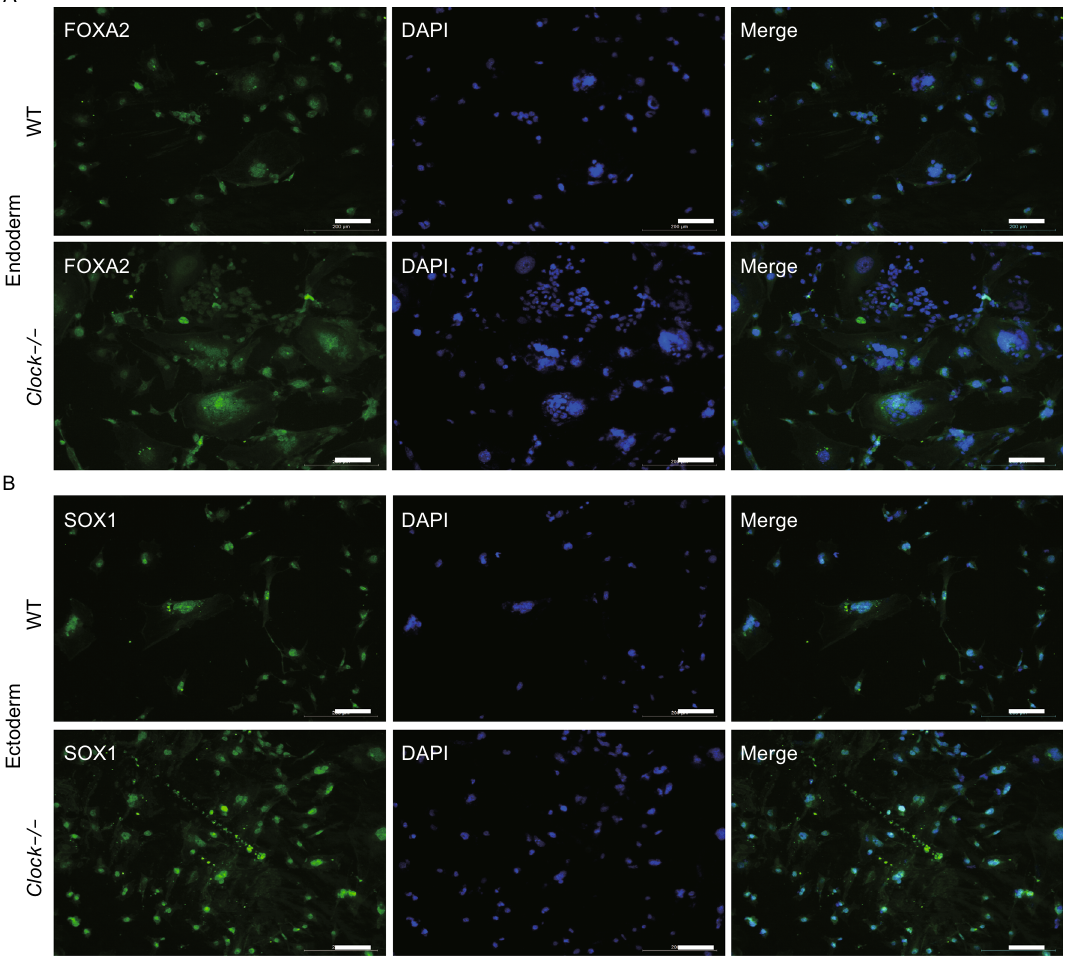
Figure 8. Clock -/- mESCs expressed higher endoderm marker FOXA2 and ectoderm marker SOX1 on day 9 after spontaneous differentiation. (A and B) Immuno fl uorescence staining of the endoderm marker FOXA2 and the ectoderm marker SOX1 in spontaneously differentiated wild type and Clock -/- mESCs on day 9. Clock -/- mESCs exhibited relatively stronger expression of both FOXA2 and SOX1. Bars, 200